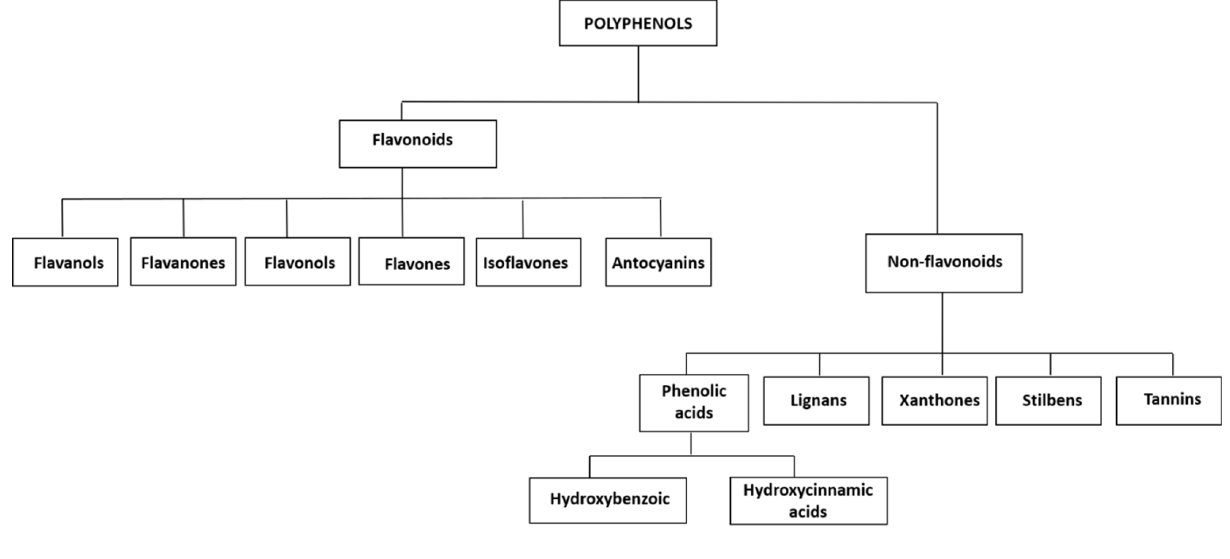
Figure 2. Polyphenols classification.